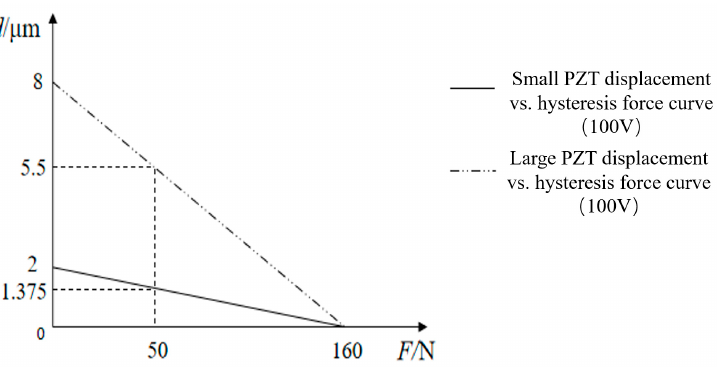
Figure 6. PZT displacement vs. hysteresis force curve.